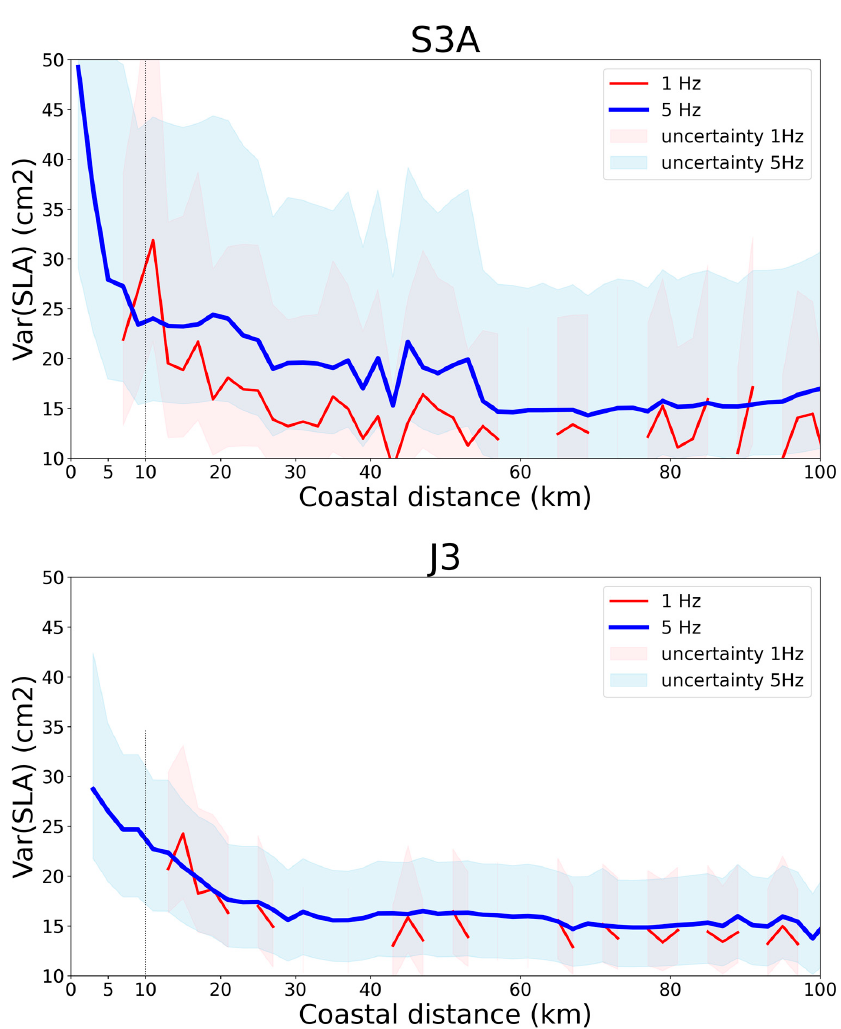
Figure 5. Mean SLA variance evolution as a function of the coastal distance for S3A (top) and J3 (bottom). Only theoretical measurement points with a minimum availability rate of 80% have been considered. Statistics over the northern Spanish coasts from 1 Hz (red) and 5 Hz (blue) products.